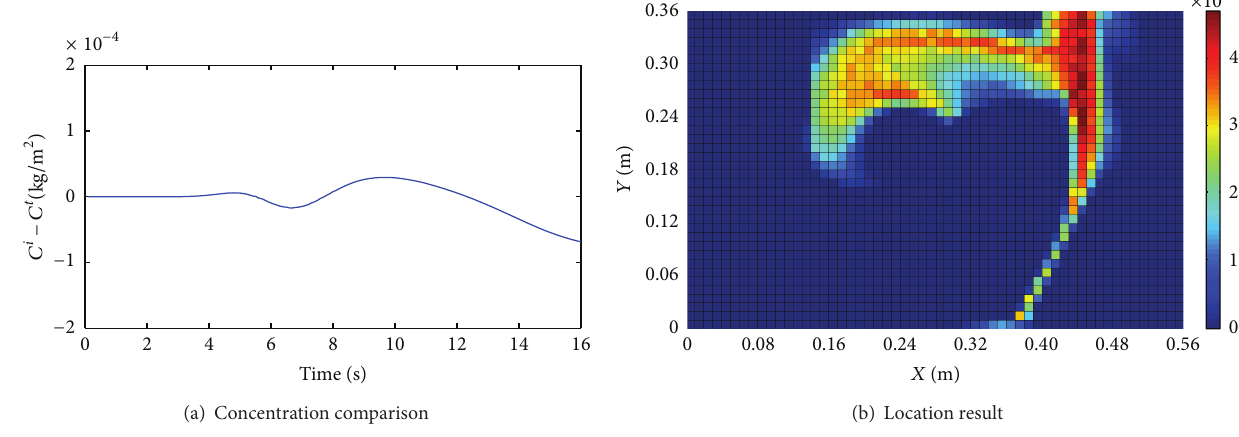
Figure 6: Results for Case 4 ( V